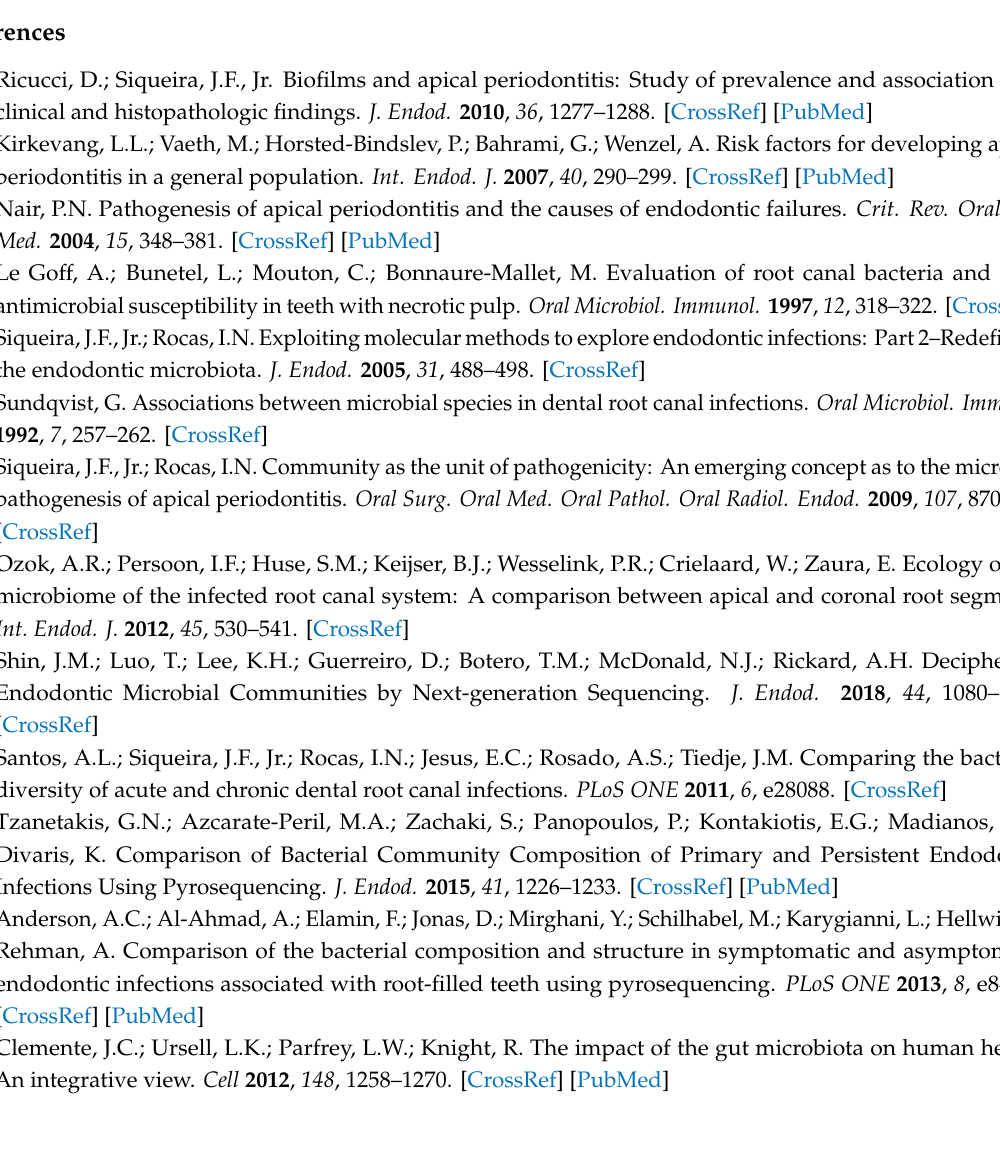
Figure S1. Histopathologic features of the G1W, G2W, and G3W groups; Figure S2. Diversity and species-level operational taxonomic units in the root apex; Figure S3. Relative abundance of bacterial phyla in the individual samples from the pulp chamber and the root apex; Figure S4. Relative abundance of bacterial species identified in the individual samples from the pulp chamber and the root apex; Figure S5: Pyrosequencing analysis of rat salivary